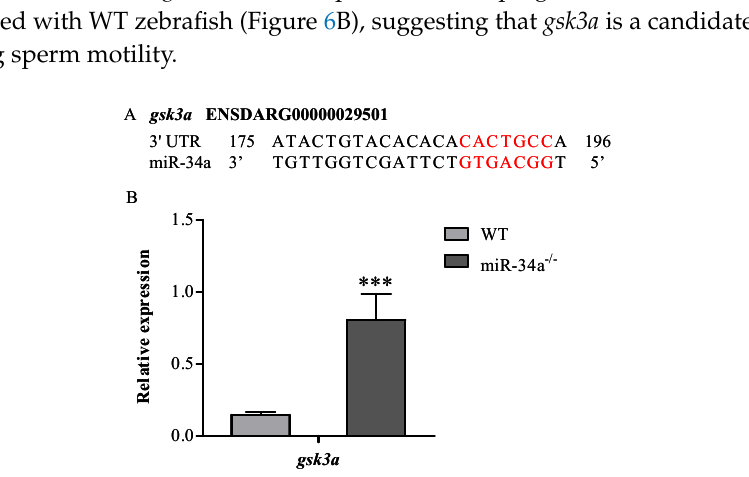
Figure 6. Knockout of miR-34a affected the expression levels of gsk3a in zebrafish testis. ( A ) The alignment of mature miR-34a with gsk3a 3 ′ UTR. Red indicates miR-34a seed sequence and the putative miR-34a binding site in gsk3a ; ( B ) The fold changes of the expression of gsk3a mRNA in the testis of WT and miR-34a − / − zebrafish examined by RT-PCR. *** p < 0.001.